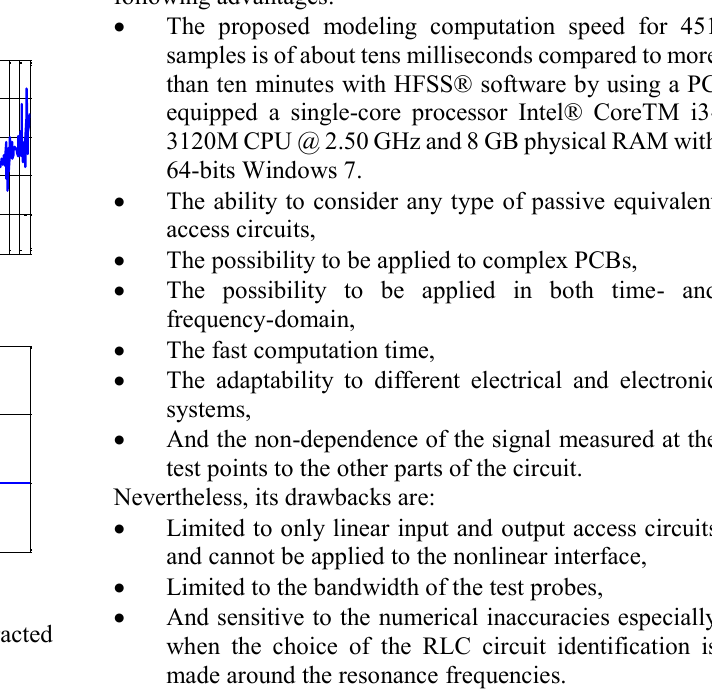
Figure 9: Transfer matrix elements: (a) T 11 and T 22 , and (b) T 12 and T 21 .